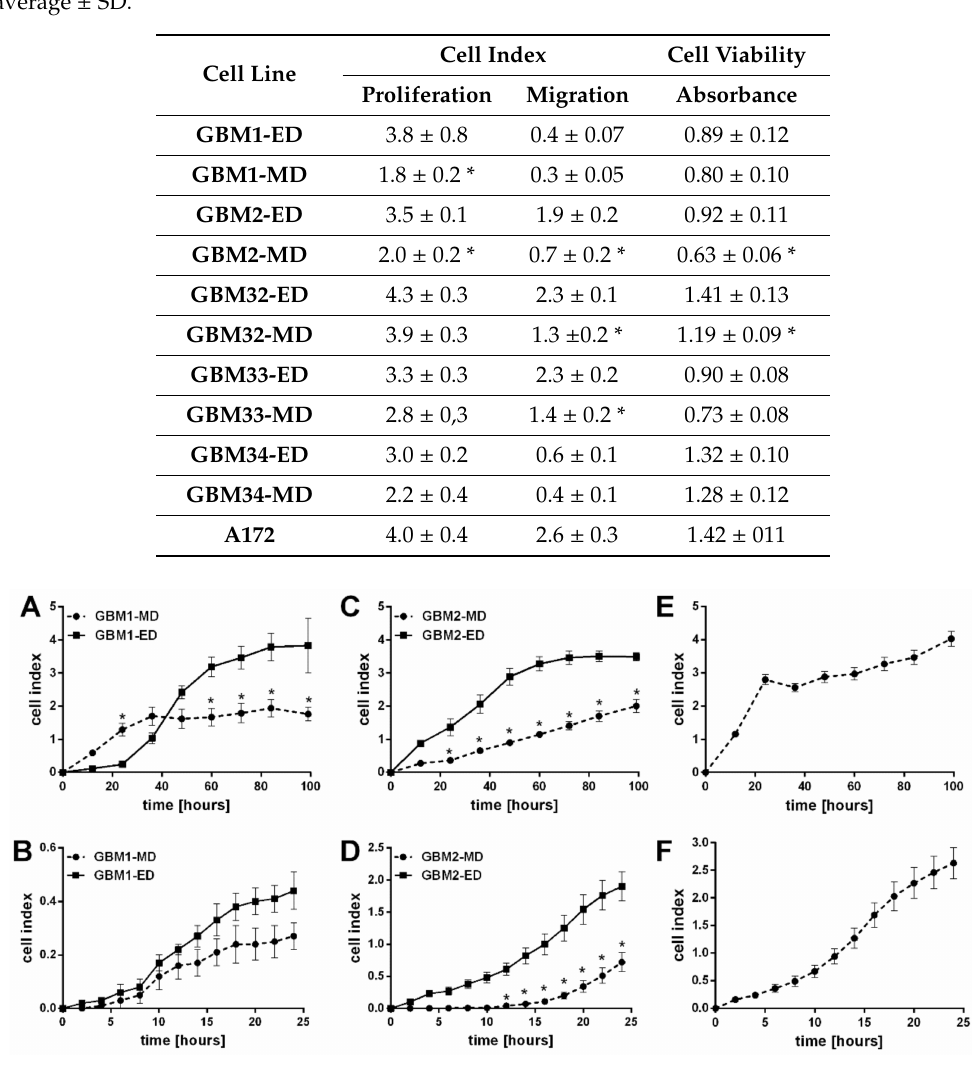
Figure 3. Proliferation ( A , C , E ) and migration potential ( B , D , F ) of primary glioblastoma cells (GBM) cells obtained from five patient samples (GBM1, GBM2, GBM32, GBM33, GBM34) with enzymatic method (ED) or mechanic method (MD) and stabilized A-172 cell line. Proliferation assay (recorded every h for 99 h) and migration assay (recorded every 10 min for 24 h) were performed using xCELLigence Real-Time Cell Analyzer as described in the Materials and Methods section. Each measurement was performed in three independent experiments. * p < 0.05 ED vs. MD; data are expressed as average ±